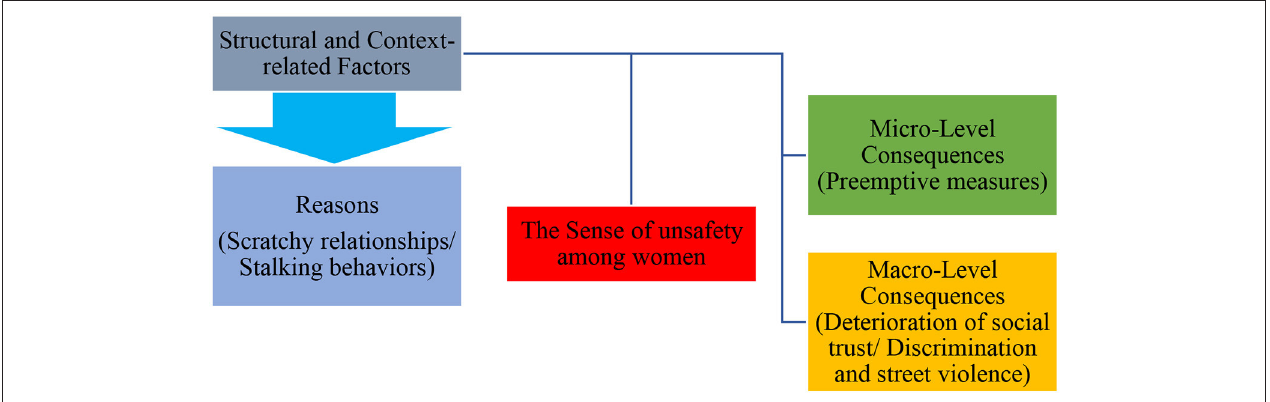
FIGURE 1 | Background model on women’s experience of feeling unsafe in public spaces in Tehran.